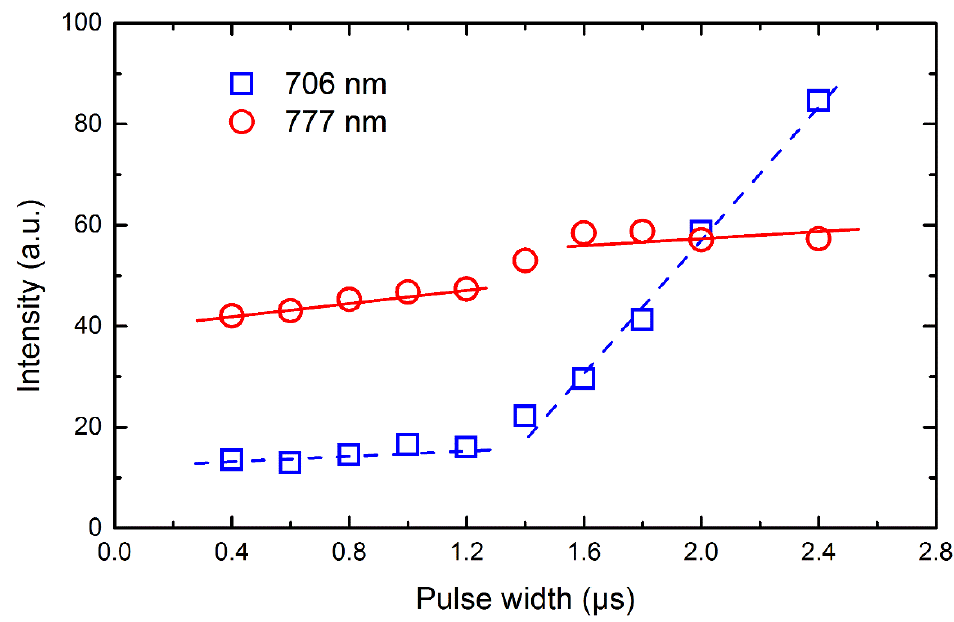
Figure 5. Temporal behaviors of optical emission intensities of He: 706 nm and O: 777 nm as a function of duration of voltage pulse.